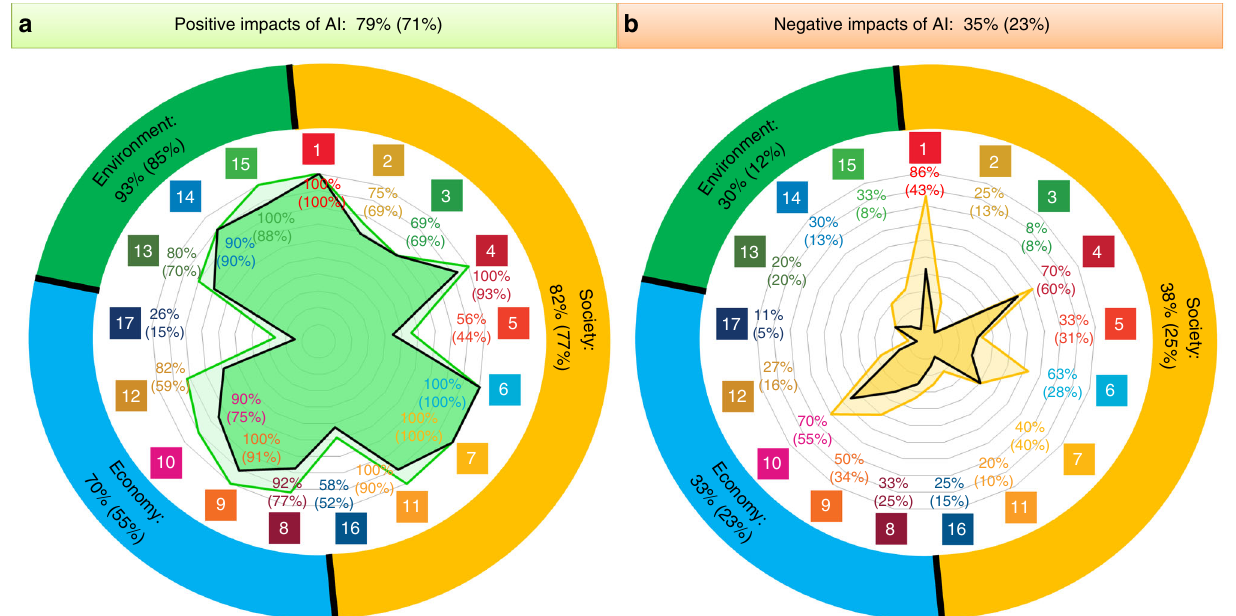
Fig. 1 Summary of positive and negative impact of AI on the various SDGs. Documented evidence of the potential of AI acting as ( a ) an enabler or ( b ) an inhibitor on each of the SDGs. The numbers inside the colored squares represent each of the SDGs (see the Supplementary Data 1). The percentages on the top indicate the proportion of all targets potentially affected by AI and the ones in the inner circle of the fi gure correspond to proportions within each SDG. The results corresponding to the three main groups, namely Society, Economy, and Environment, are also shown in the outer circle of the fi gure. The results obtained when the type of evidence is taken into account are shown by the inner shaded area and the values in